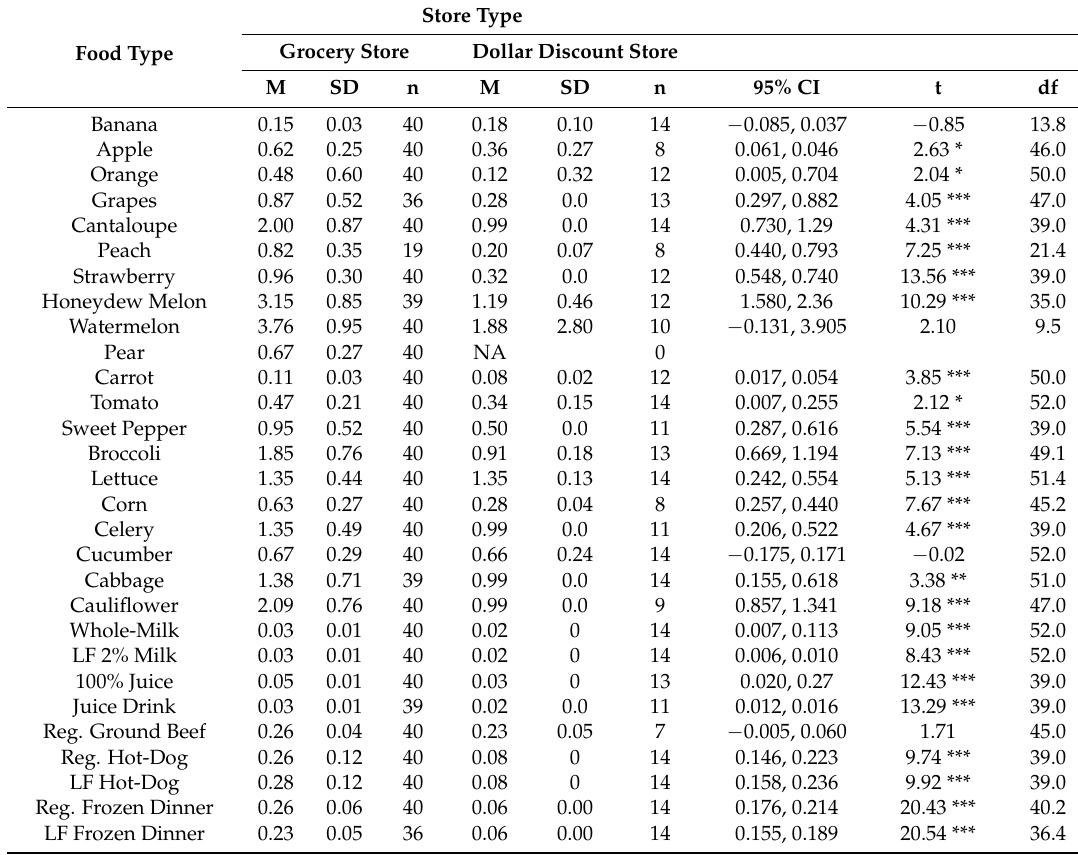
Table 1. t -test results for price of each produce and food item at grocery ( n = 40) and dollar discount stores ( n = 14) in Las Vegas Metropolitan area in summer